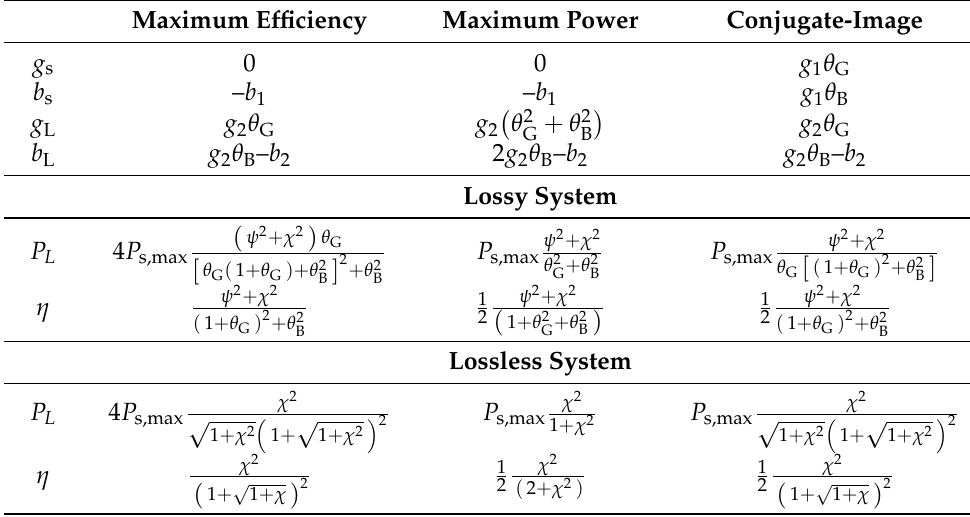
Table 1. A summary of the three